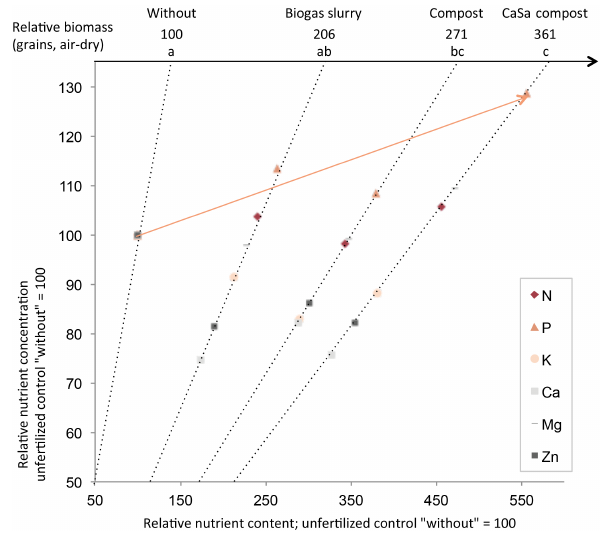
Figure 4. Vector nutrient analysis for maize, showing the responses of air-dry grain yield (gplant − 1 ), relative nutrient concentration in DM (with the untreated Andosol: 100%) and relative nutrient up- take (with the untreated Andosol: 100%). Different letters reflect means differing significantly from one another (HSD, Tukey test, α = 0.05; n = 3). The arrow indicates the largest response and de- picts a primary response of maize plants to mitigated P deficiency. Plot data are provided in Table